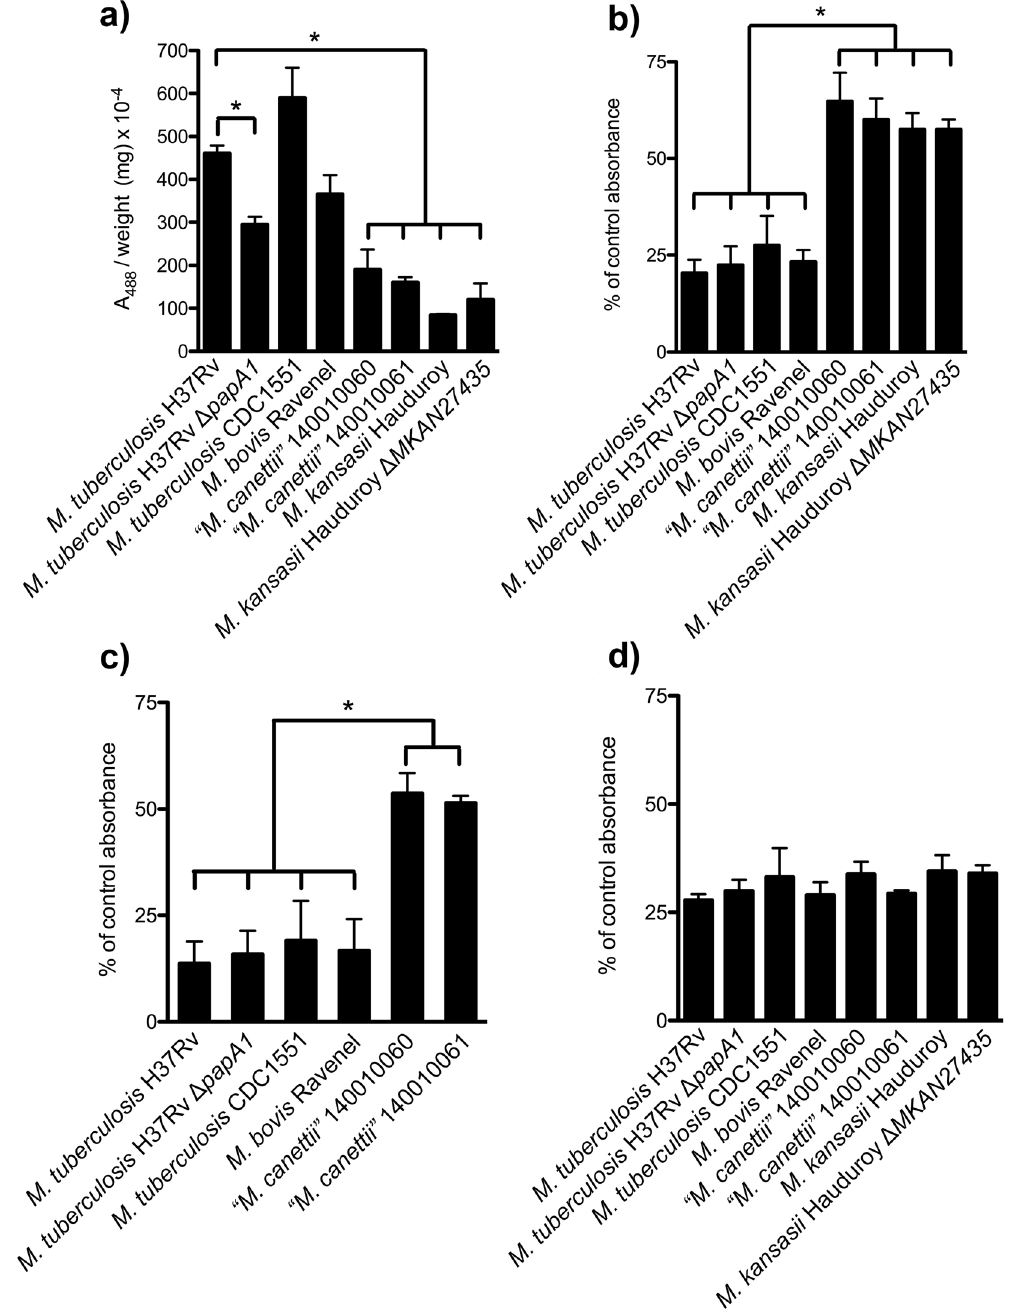
Figure 3. Quantitative assessment of relative mycobacterial hydrophobicity. ( a ) Quantification of Congo Red extracted from solid media growth. Hexadecane/aqueous buffer partitioning of: (b) Live cells, ( c ) Killed cells, ( d ) Defatted killed cells. Results are expressed as mean ± standard deviation of at least three independent experiments. Statistical significance was determined by Student’s t -test (p <